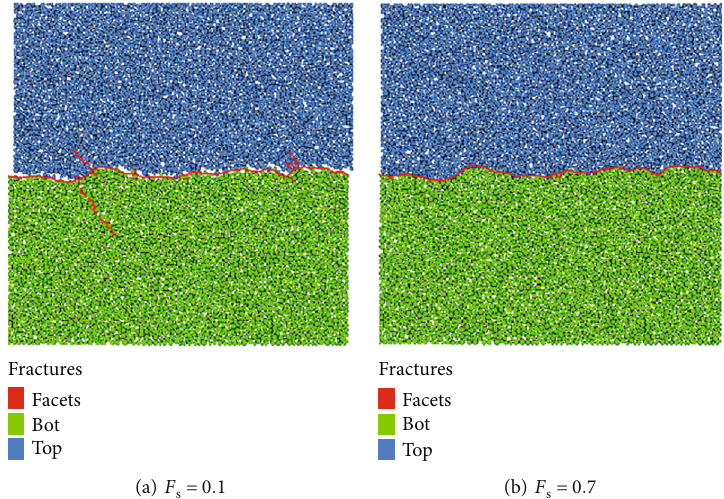
Figure 14: Number of sample cracks under di ff erent friction coe ffi cients F